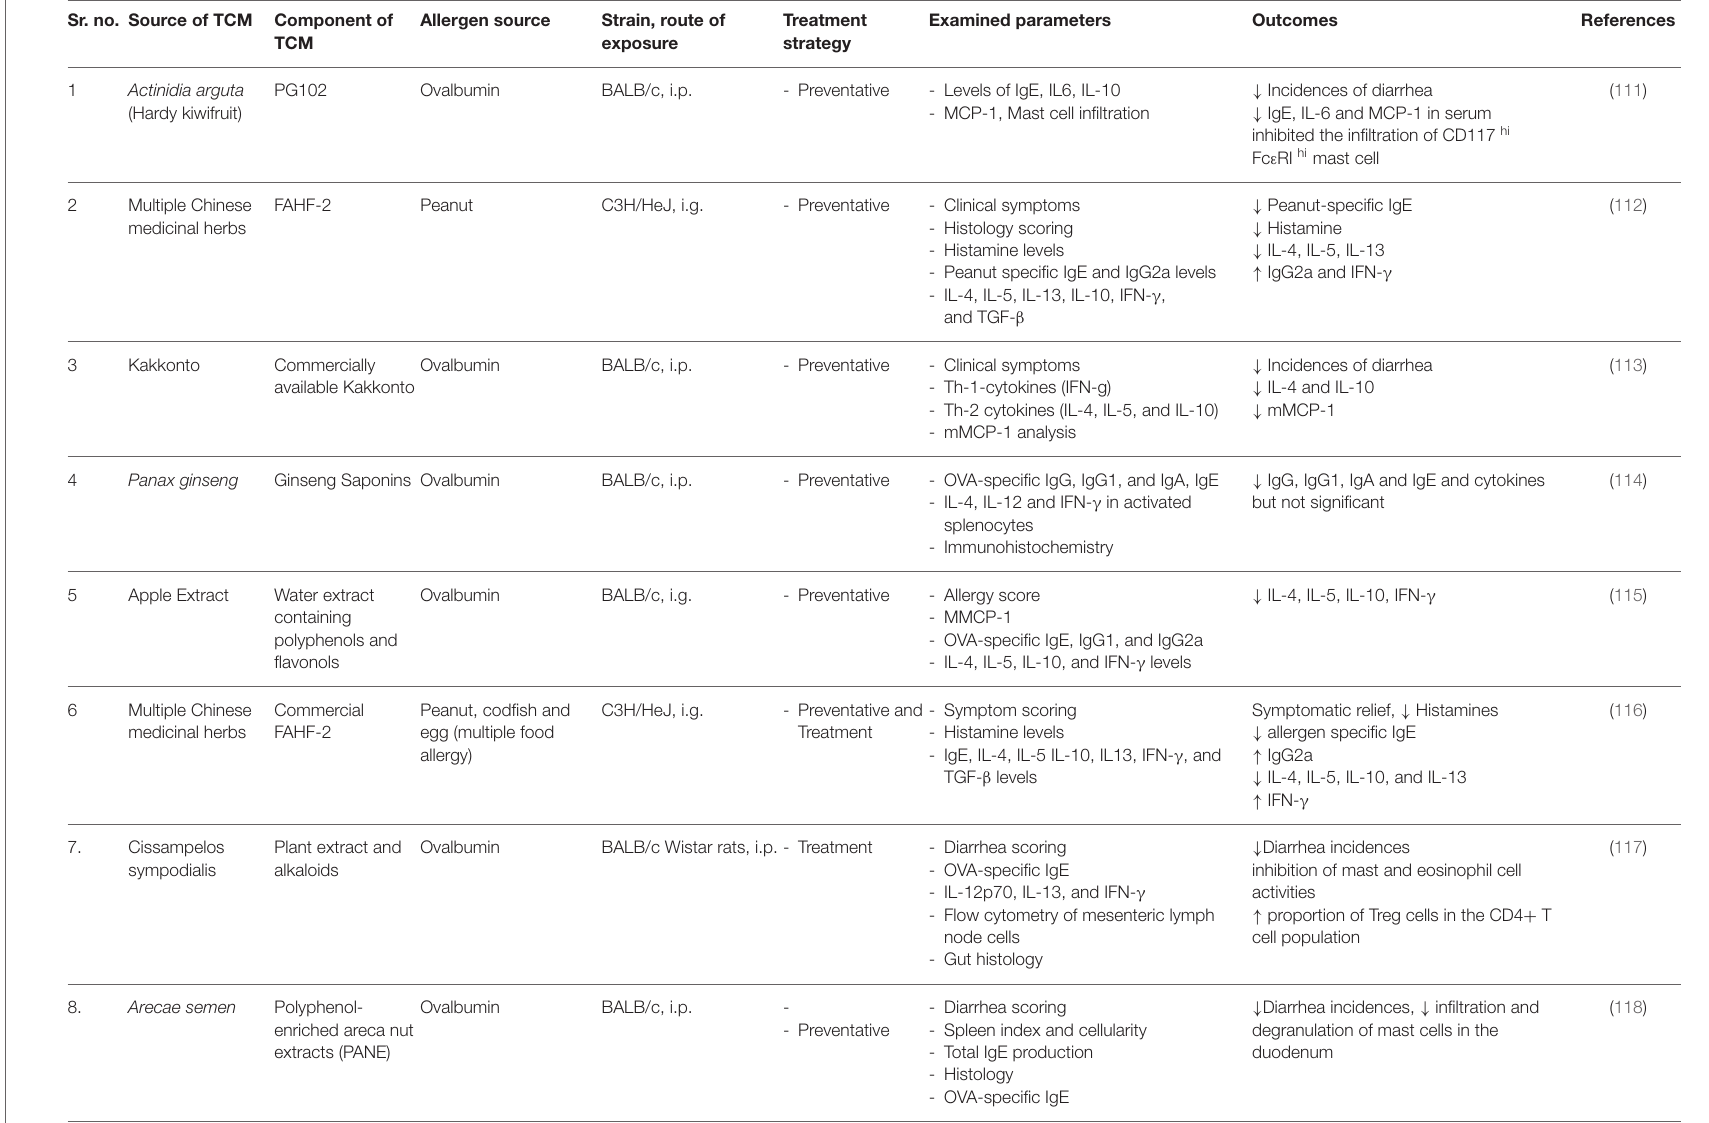
TABLE 2 | A summary of studies investigating the immunomodulatory effects of traditional Chinese medicine and other medicinal plants, tested for preventative (prophylactic) or treatment (curative) strategies, using mouse models of food allergy. Sr. no. Source of TCM Component of